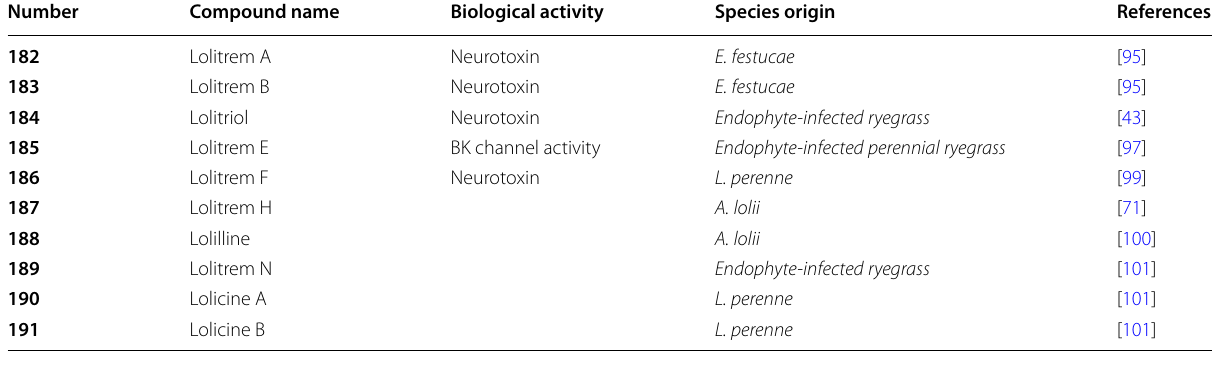
Table 12 Name, bioactivities and source of compounds with A‑ring 5/6 member ring